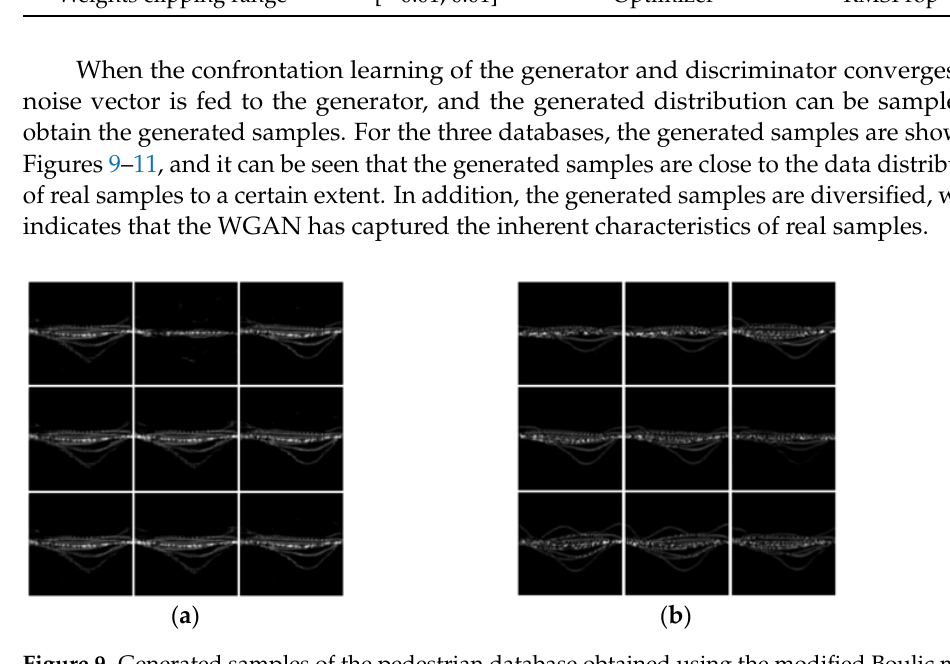
( a ) Armed pedestrian; ( b ) unarmed pedestrian.